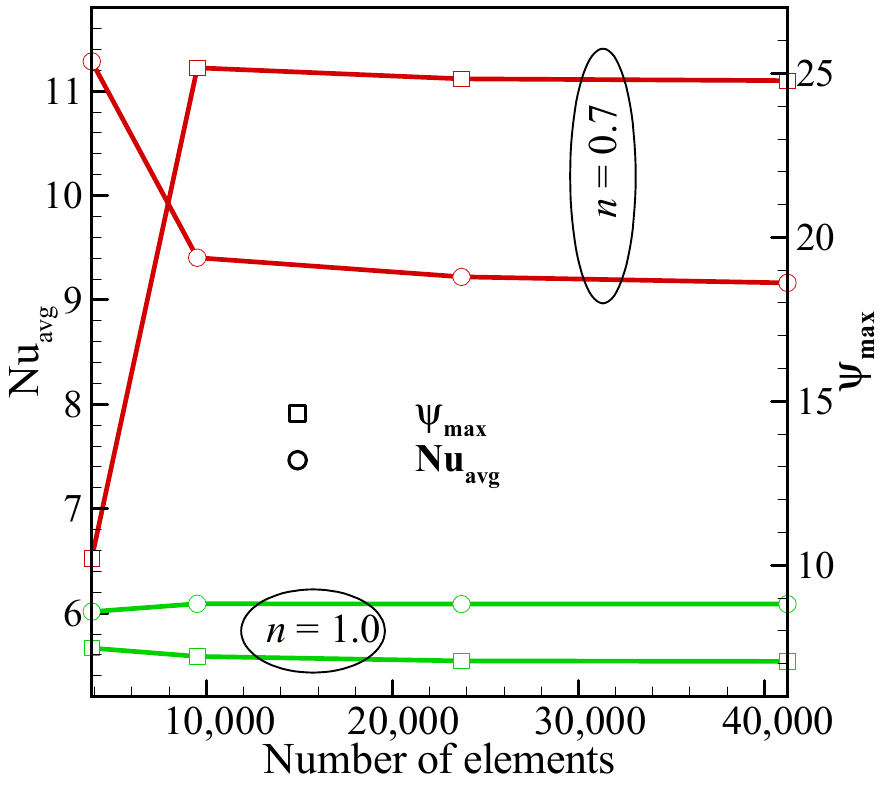
Figure 2. Dependence of the average Nusselt number, Nu inside the cavity, ψ max , on the number of elements in the mesh used for numerical simulation.